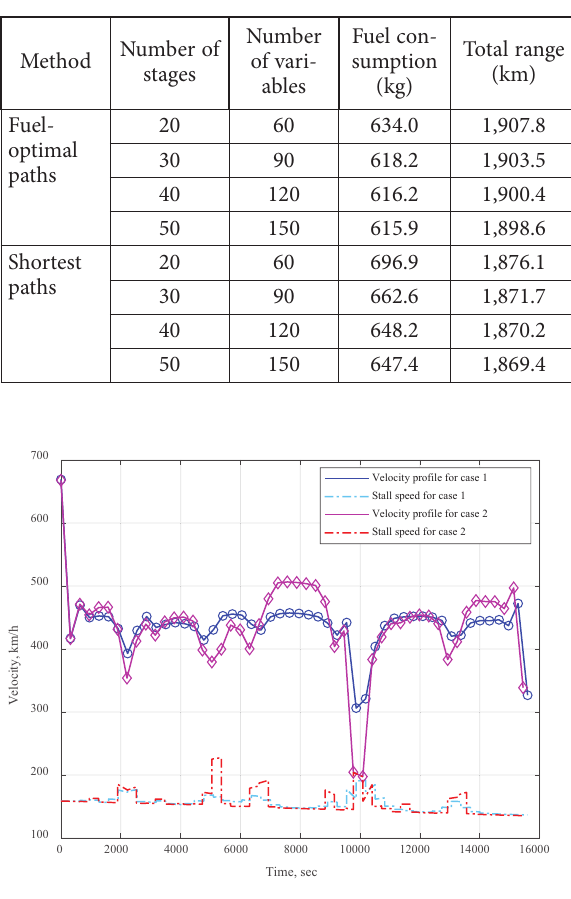
Figure 9. Optimal velocity profiles for two simulations with 50 stages in scenario 2